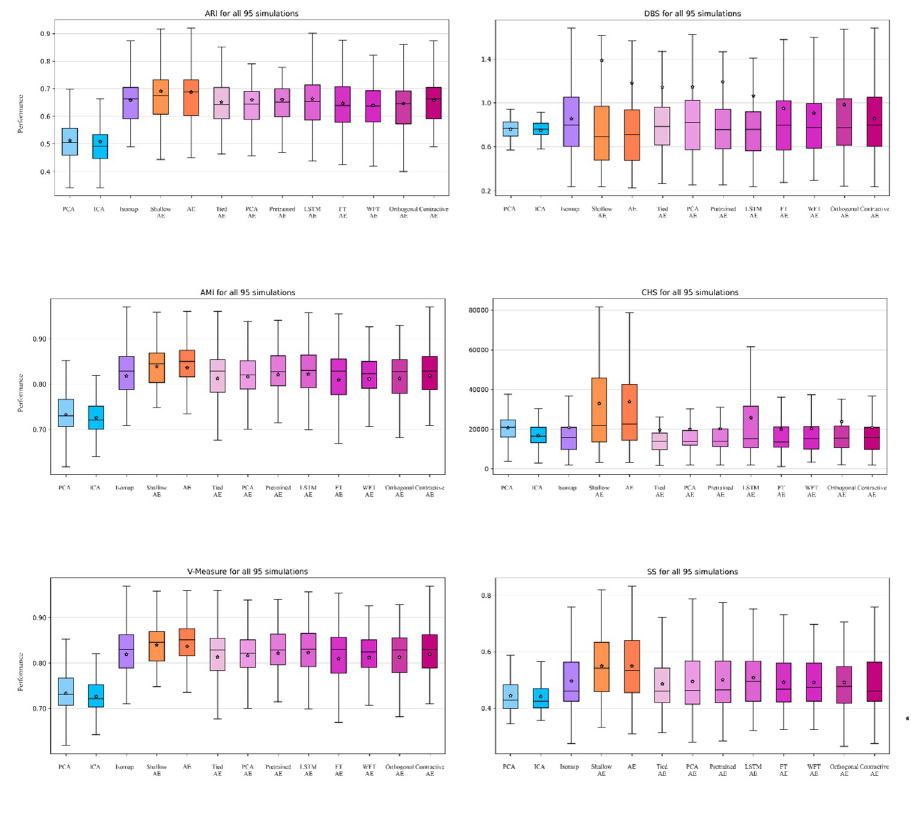
Fig 5. Analysis of all methods on 95 synthetic datasets. Performance evaluation of the classical feature extraction methods and the autoencoder variants for each metric on all 95 synthetic datasets, the star represents the average value.